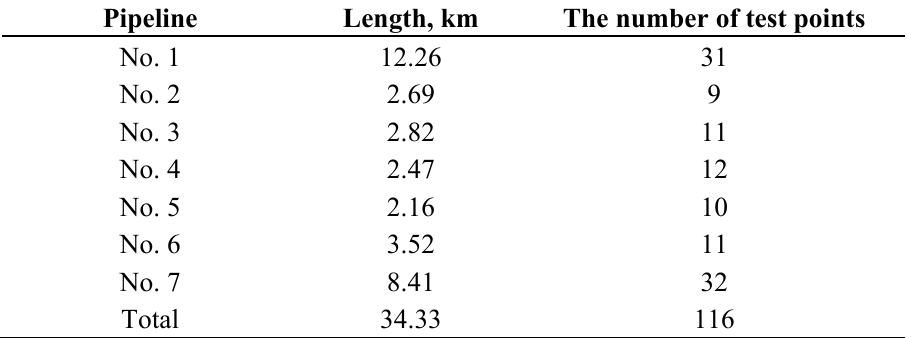
Table 6. The internal corrosion inspection data from the